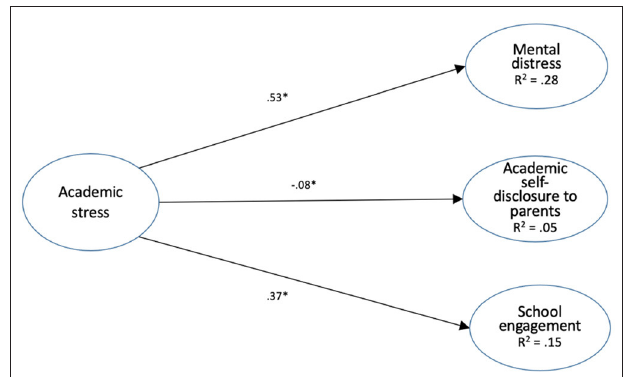
FIGURE 1 | Structural equation modeling of the direct effect of academic stress on mental distress, academic self-disclosure to parents and school engagement (numbers are standardized effects. *Indicates statistical significance at p < 0.01.).